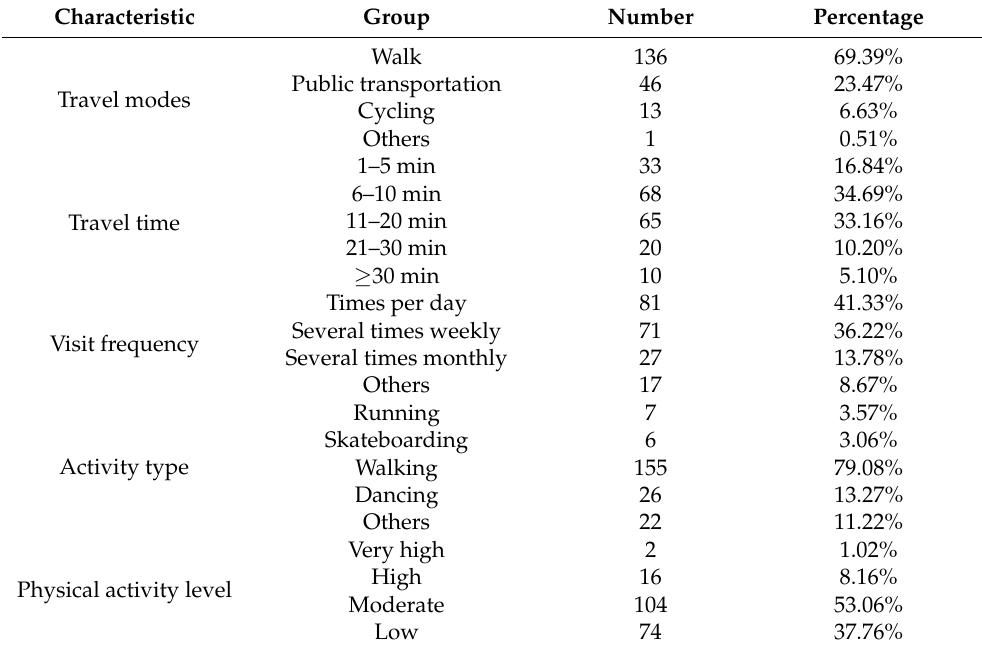
Table 3. Physical activity in the public